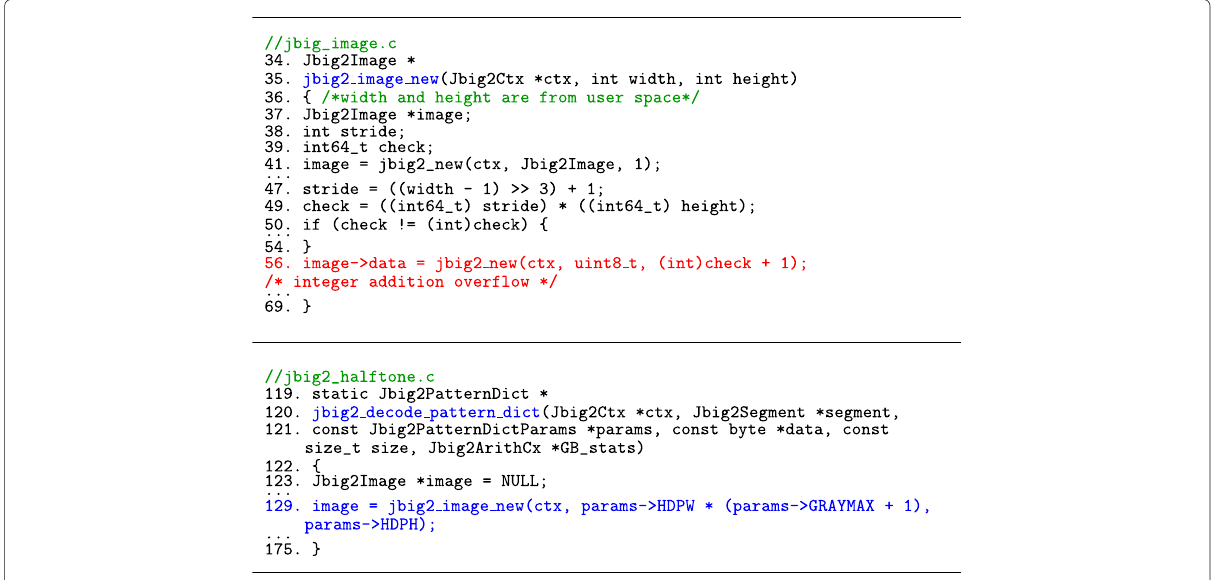
Fig. 2 A real-world IO2BO vulnerability in Jbig2dec